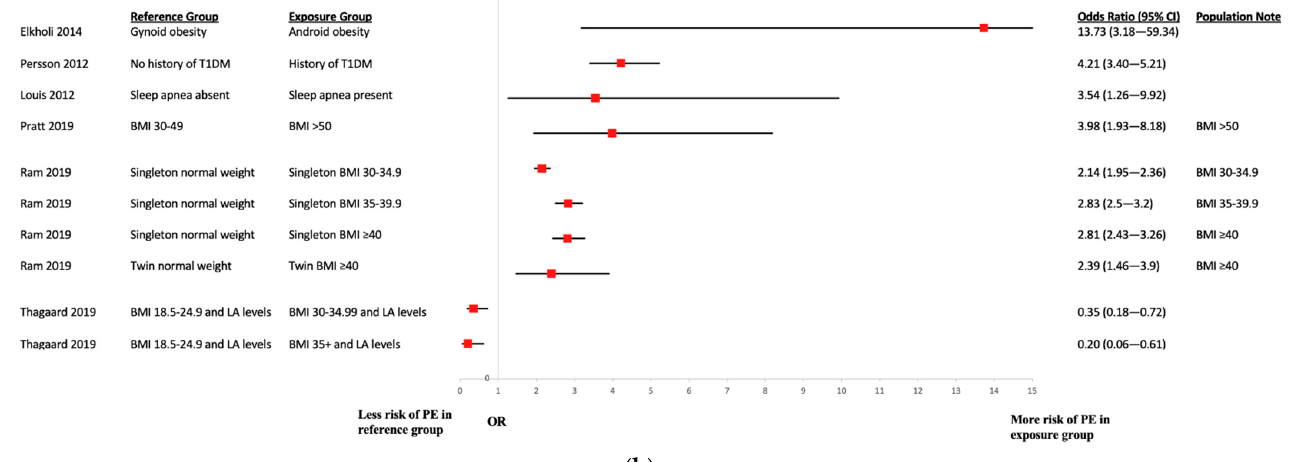
Figure 3. ( a ) PE Age and Race. Acronyms: BMI = body mass index; CI = confidence interval; PE = preeclampsia. ( b ) PE Risk Factors. Acronyms: BMI = body mass index; T1DM = type 1 diabetes mellitus; LA= log adiponectin; CI = confidence interval; PE = preeclampsia.